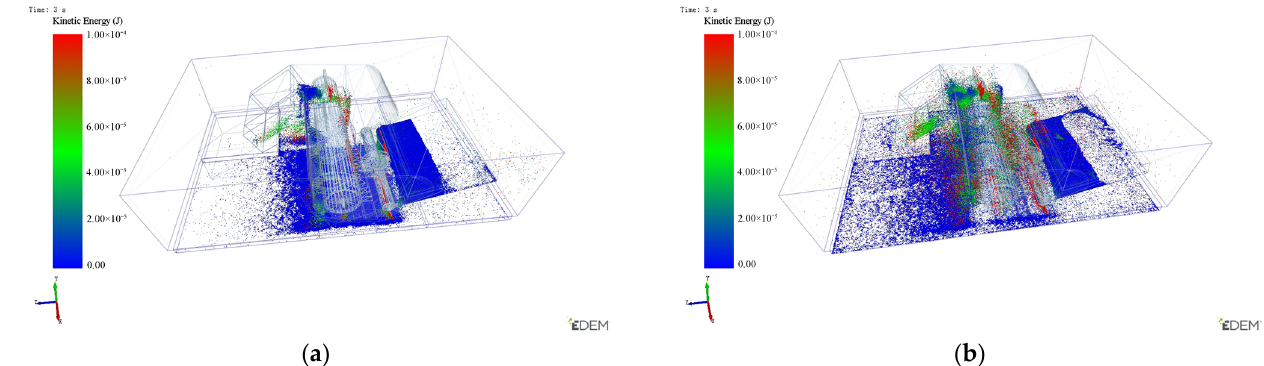
Figure 10. Kinetic energy simulation comparison diagram: ( a ) sandy soil removal process without vibratory action; ( b ) sandy soil removal process with vibratory action.